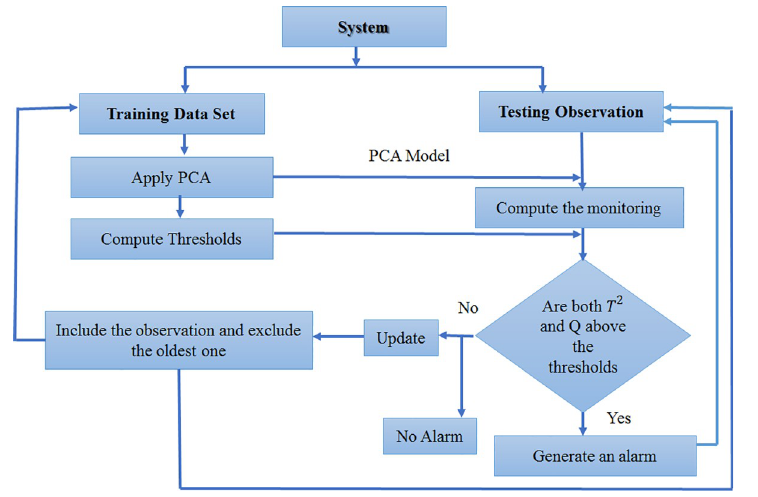
Fig 3. Moving window PCA flowchart